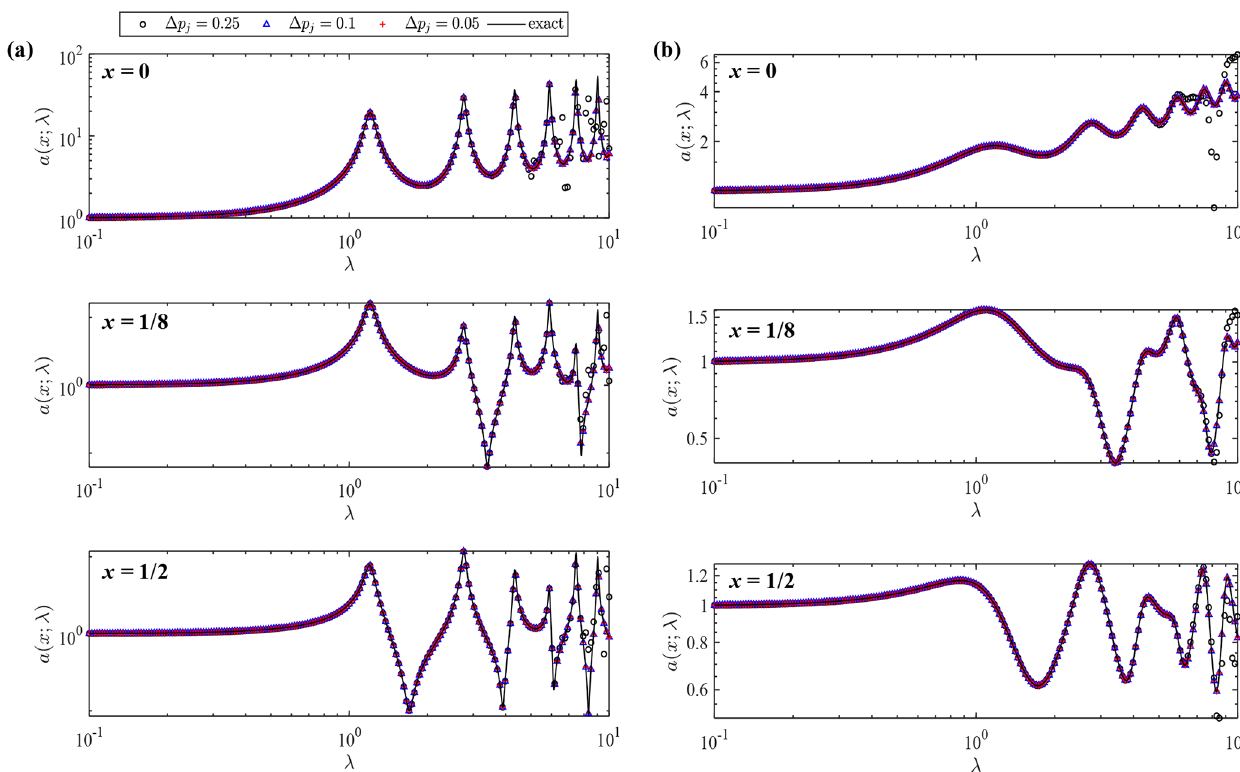
Figure 5. Wave amplitude a as a function of dimensionless angular frequency λ at different locations ( x = 0, x = 1 / 8 and x = 1 / 2) for damping coefficients (a) α = 0 . 1 and (b) α = 1 . 0. Each panel shows exact and numerical solutions with different integration subintervals (cid:49)p j = 0 . 05, (cid:49)p j = 0 . 25 and (cid:49)p j = 0 . 1.